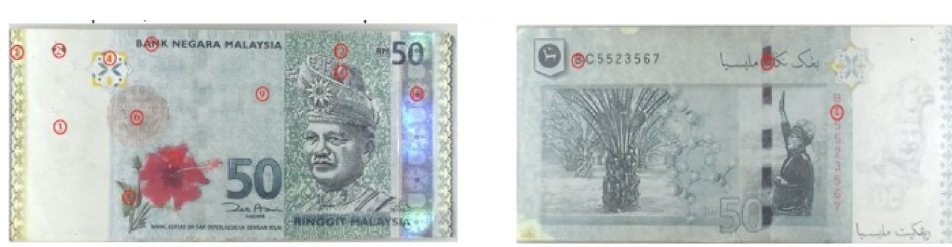
Figure 7. The RM 50’s marked